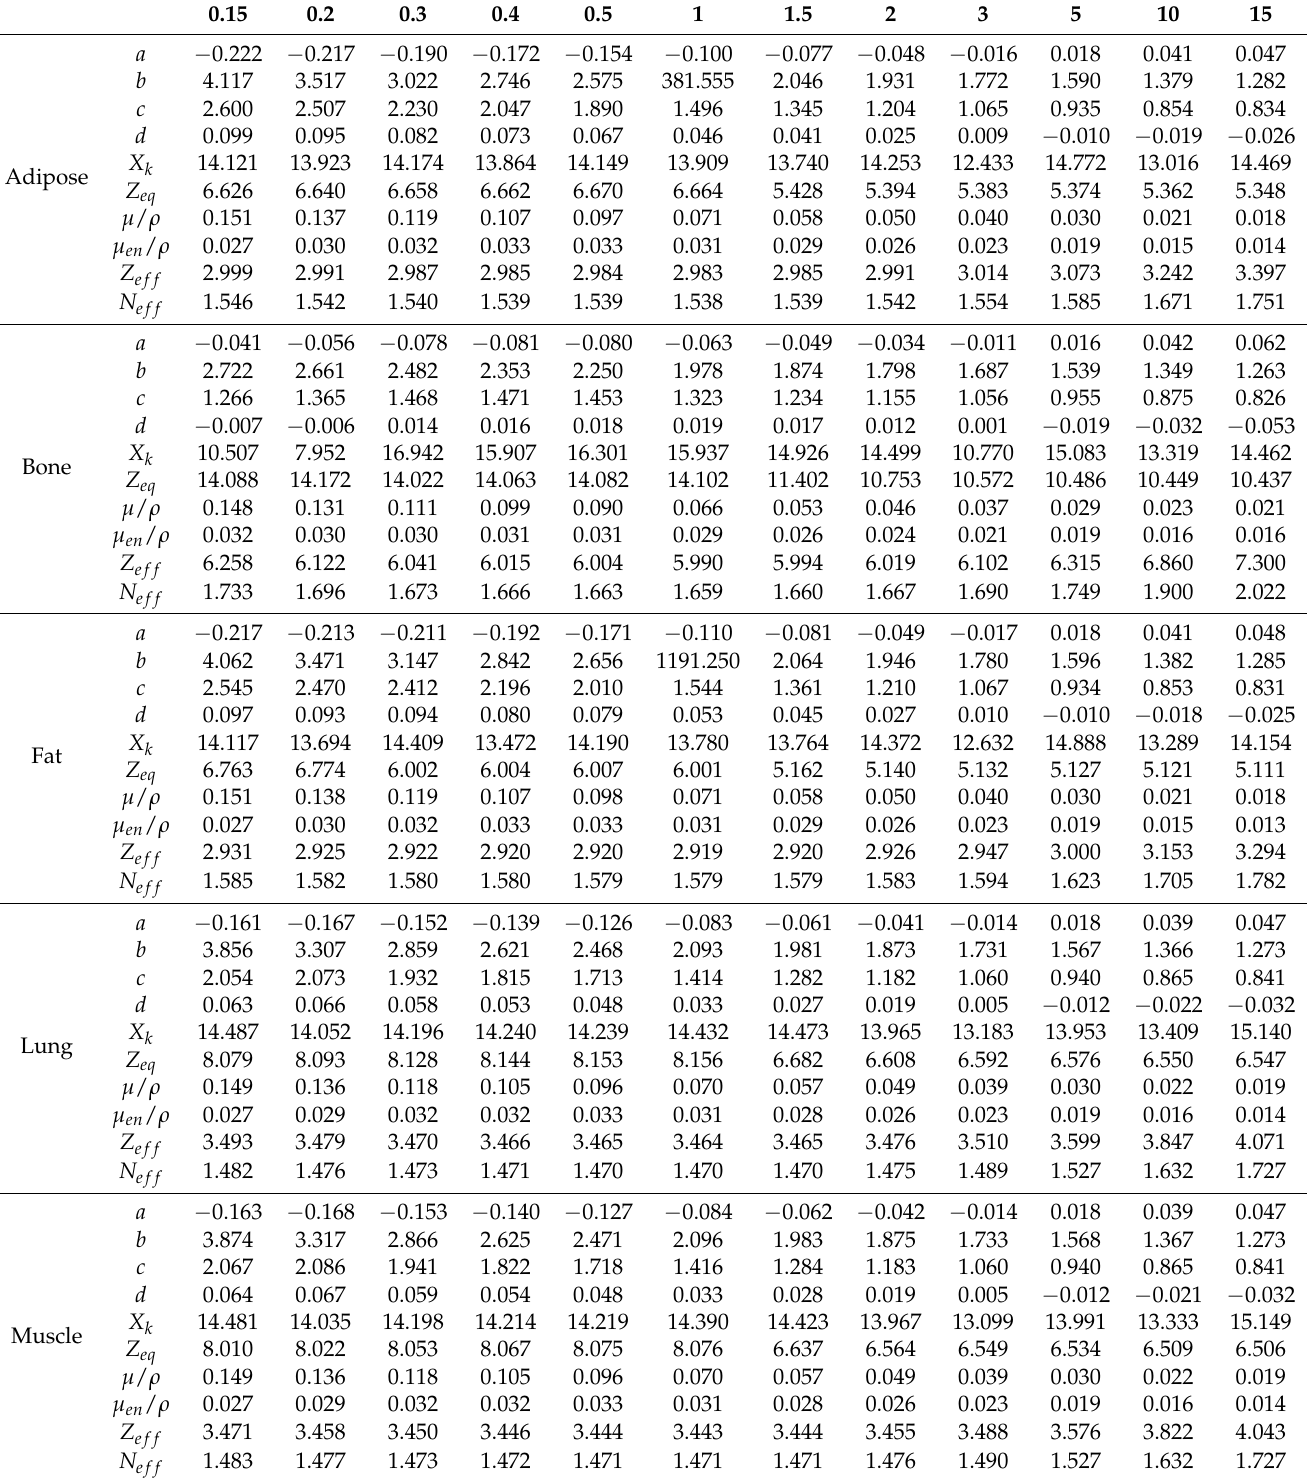
Table 2. Physical properties of the studied tissues: GP-fitting parameters of the BUF ( a , b , c , d and X k ), equivalent atomic number ( Z eq ), mass attenuation coefficient ( µ / ρ ), mass energy absorption coefficient ( µ en / ρ ) in cm 2 /g and effective electron density ( × 10 − 23 ) at different photon energies between 0.15 and 15